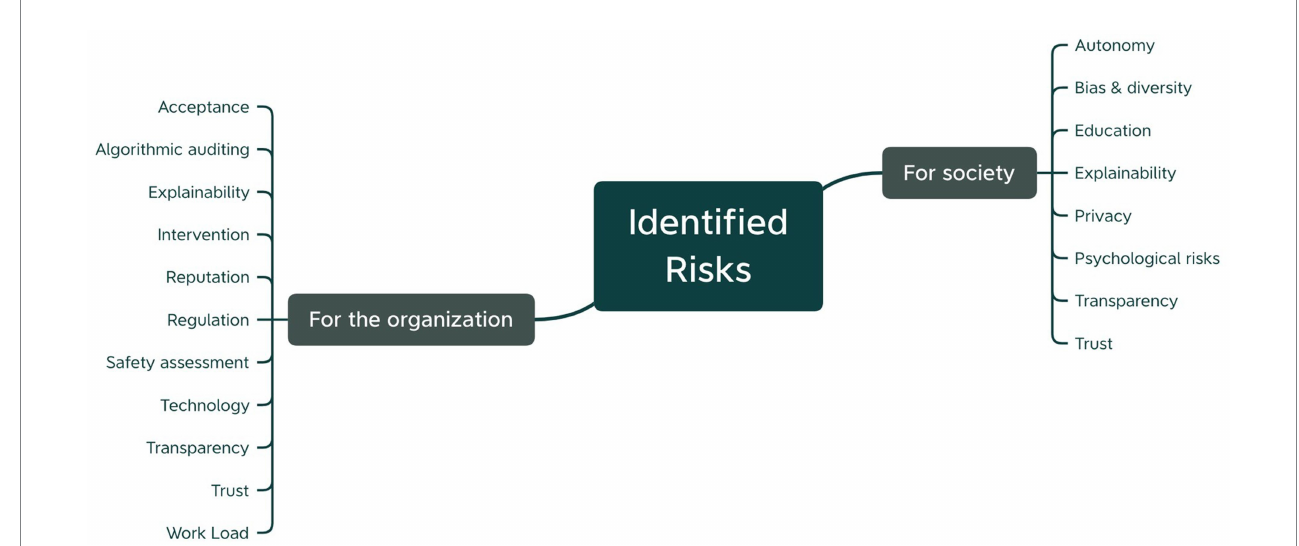
FIGURE 6 Risks identified by the participants during the workshop structured according to the actor they impact.